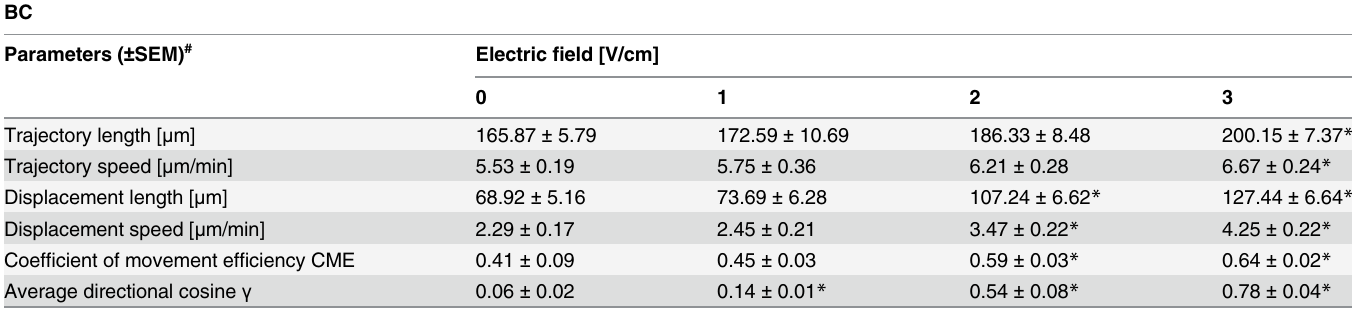
Table 2. Parameters characterizing BC cell migration under isotropic conditions and after the application of an electric field. BC